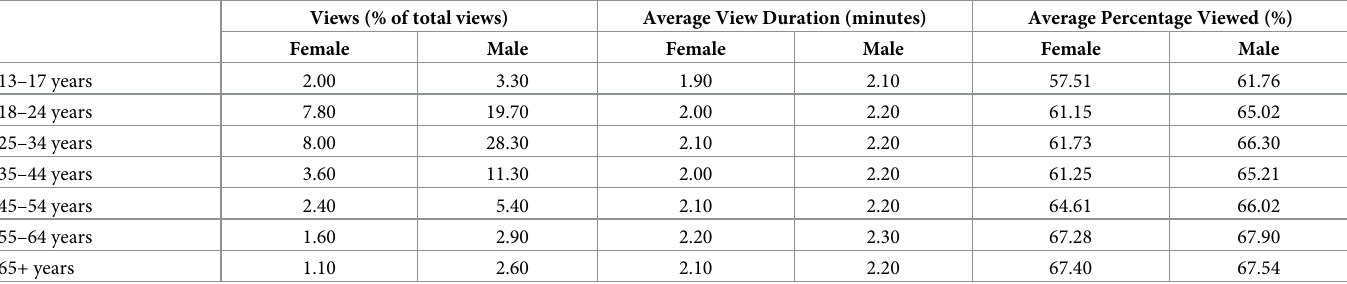
Table 1. Viewership by age and gender.